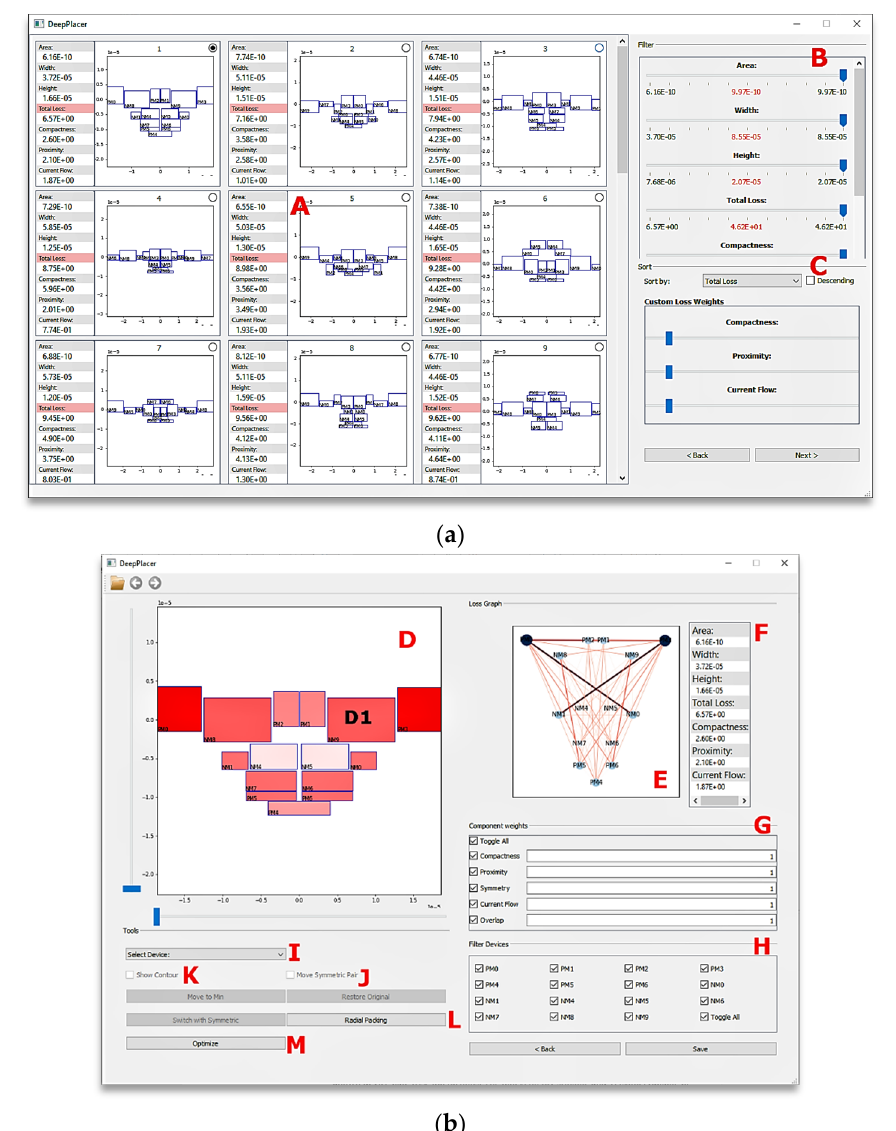
Figure 3. GUI: ( a ) Placement inspection, selection, interface; ( b ) Placement analysis and fine-tuning interface. Total error shown.